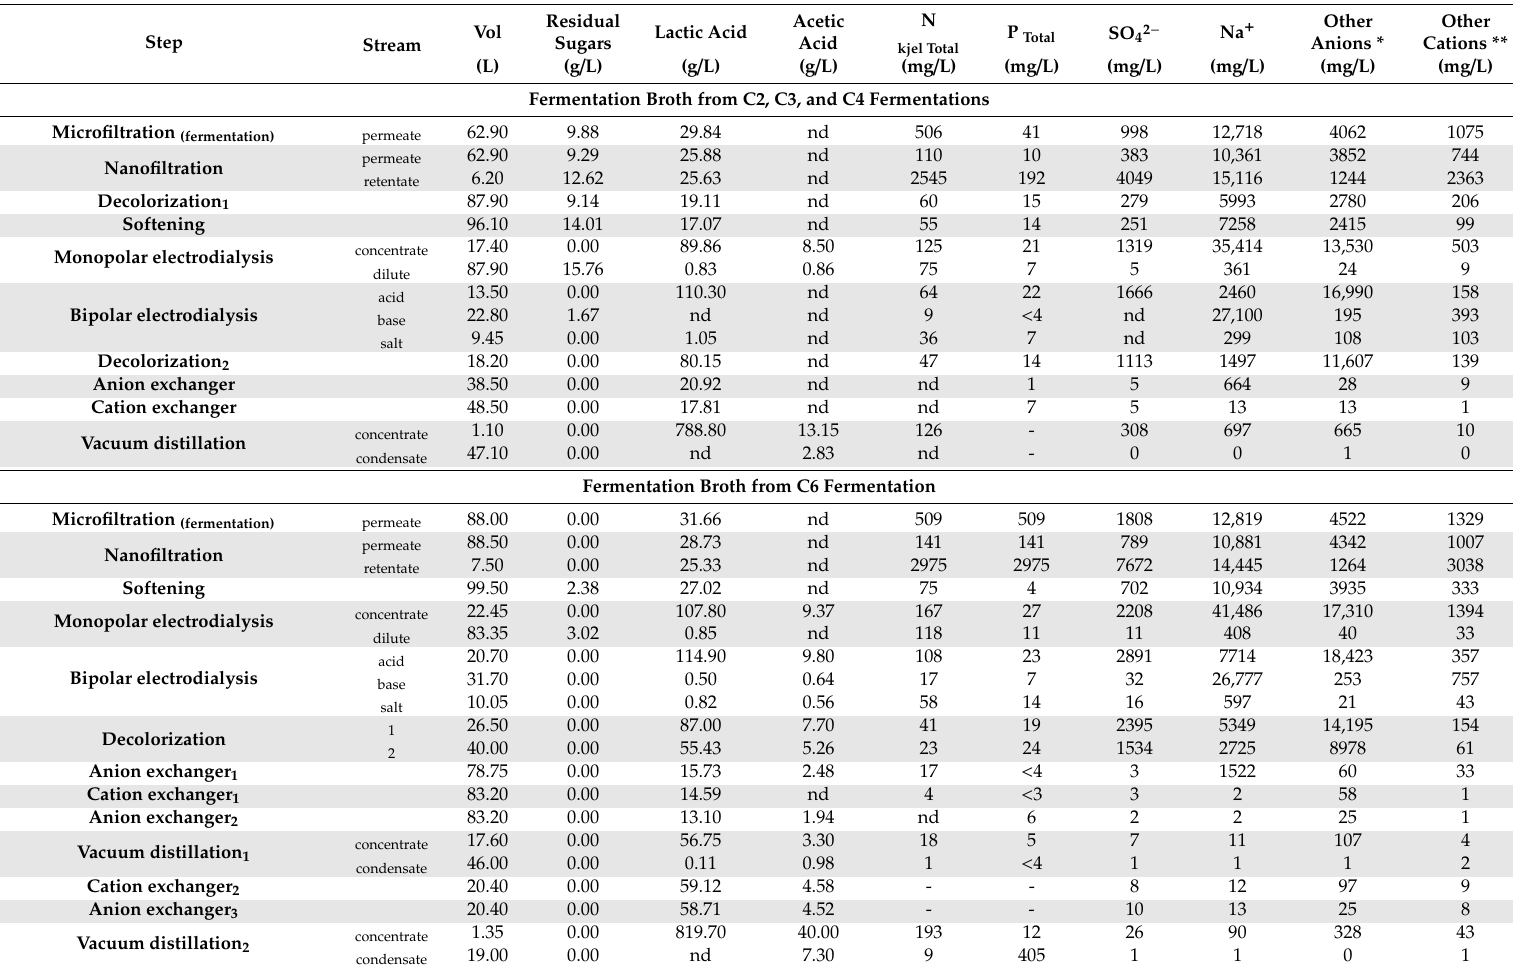
Table 3. Composition of the streams resulting from the lactic acid downstream process based on bipolar membrane electrodialysis.